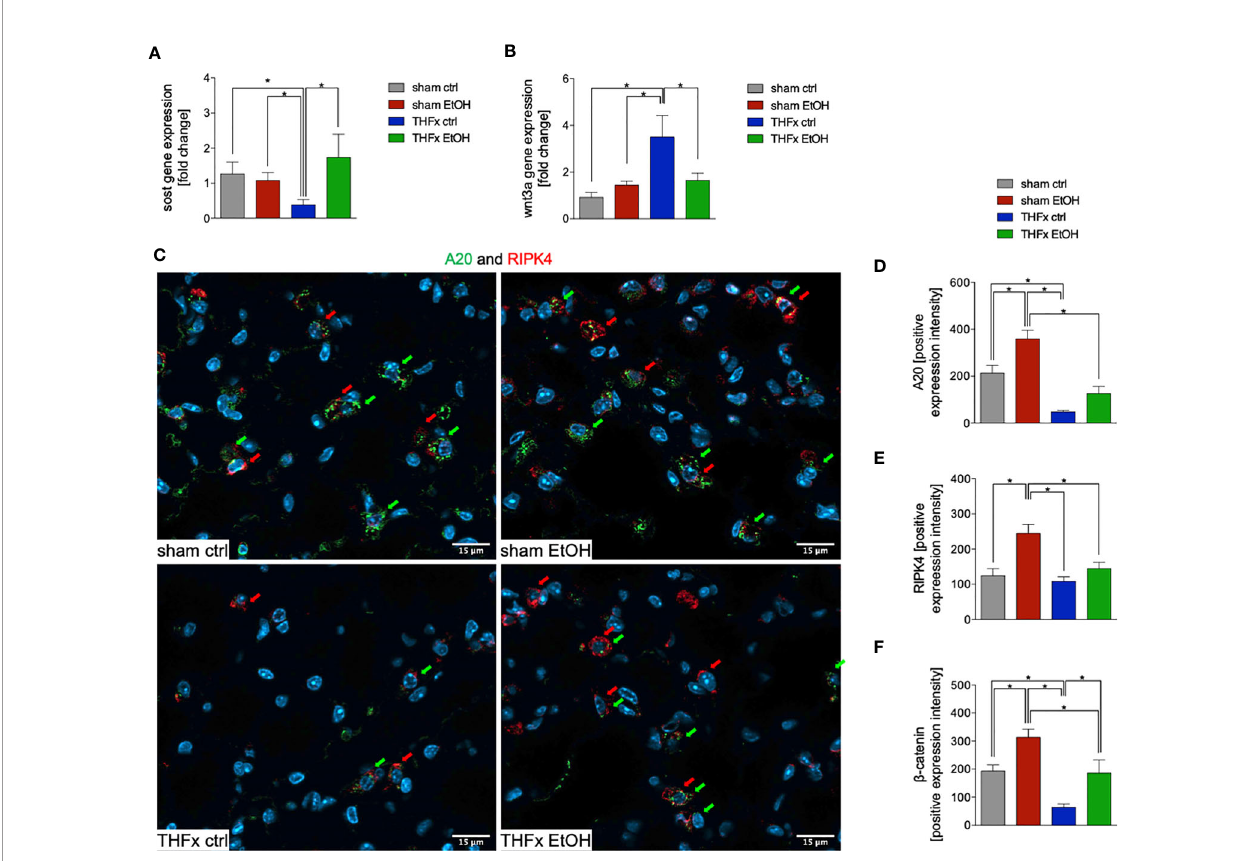
FIGURE 4 | Impact of acute ethanol intoxication (EI) on Wnt signaling and A20 after femoral fracture (Fx) and hemorrhagic shock (HS, THFx respectively). The animals received an intragastric gavage of either sodium chloride (ctrl, n = 14) or ethanol (EtOH, n = 14) to simulate an acute intoxication with alcohol. Two hours before the initiation of experiments, the animals in trauma groups underwent an Fx ( via osteotomy after the placement of an external fi xator) and a pressure- controlled HS with subsequent resuscitation with Ringer ’ s solution (THFx) via catheterized femoral artery ( n = 14). Sham groups underwent catheterization and received an external fi xator, but THFx was not induced ( n = 14). Twenty-four hours after the end of the experiment, mice were euthanized, and sampling was performed. Wnt3a and its inhibitor sclerostin (Sost) were determined. (A) RT-qPCR of homogenized lung tissue was performed. The relative gene expression of Sost, an Wnt inhibitor, normalized to Gapdh was calculated by using the comparative threshold-cycle 2 − DD CT method. (B) RT-qPCR of Wnt3a is shown after Wnt3a relative gene expression normalization to Gapdh by using the comparative threshold-cycle 2 − DD CT method. (C) Representative immuno fl uorescent staining of A20 in green (green arrows, Alexa Fluor 488) and receptor interacting protein kinase 4 in red (RIPK4, red arrows, Alexa Fluor 647) are represented. (D) Quanti fi cation of A20- positively stained cells per high-power fi eld (HPF) is shown. (E) Quanti fi cation of RIPK-4 positively stained cells per HPF is shown. (F) Immuno fl uorescence staining of the b -catenin as the key mediator of the Wnt/ b -catenin signaling pathway in lung sections of mice was performed, and quanti fi cation of the positively stained area per HPF is depicted. Data are presented as mean ± standard error of the mean; n = 7 in all groups, * p < 0.05 between indicated